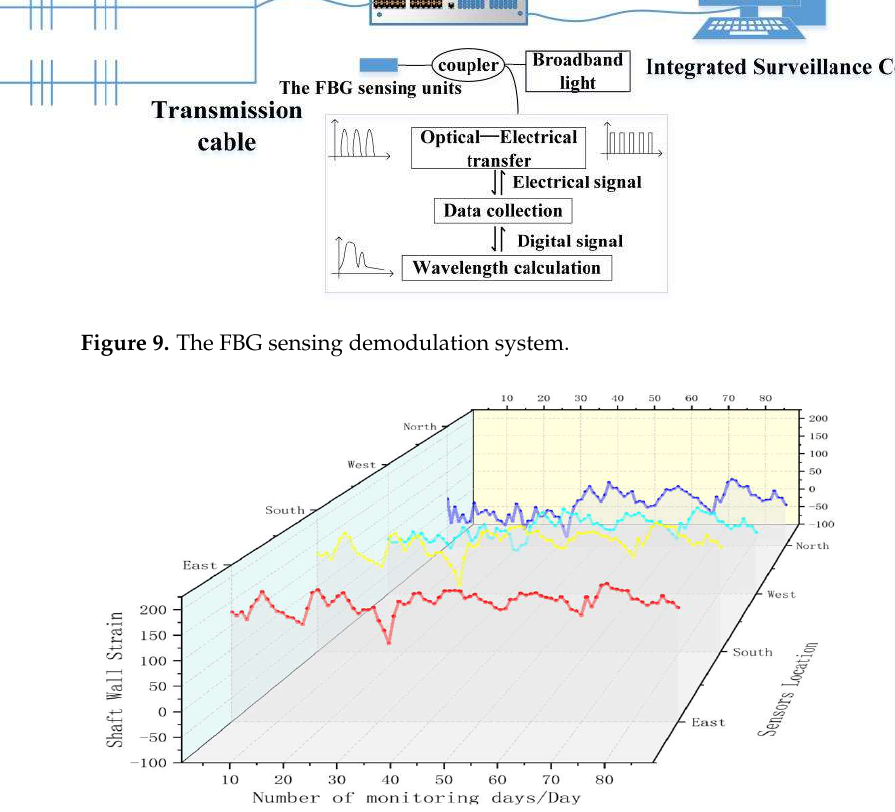
Sensors 2022 , 22 , x FOR PEER REVIEW 15 of 18